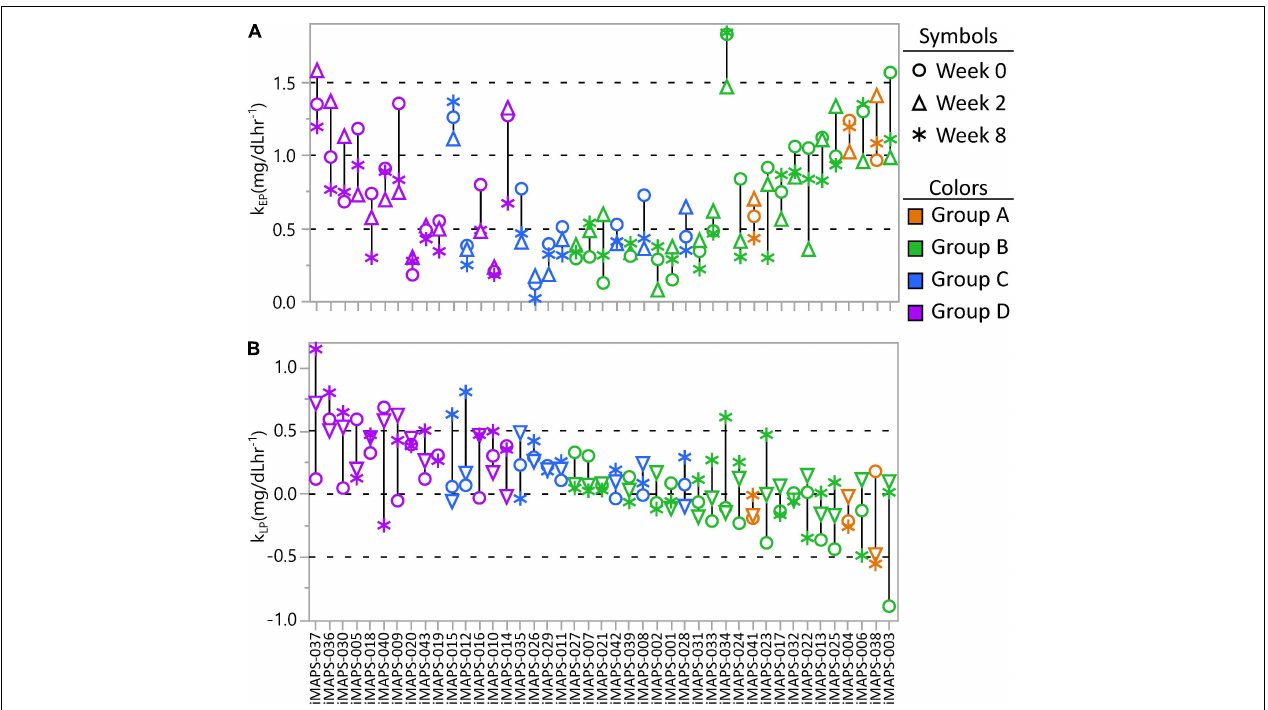
FIGURE 7 | The intra-individual variance in (A) early-phase postprandial triglyceride change (k EP ) and (B) late-phase postprandial triglyceride change (k LP ) from the plasma measured at 0, 2, and 8 weeks of the iMAPS dietary intervention. The 43 participants are ordered by decreasing k EP x k LP and colored by the median k EP x k LP kinetic quartile group (A, B, C, or D) of the three measurements. Considering all participants, and controlling for the participant as a random effect, EP increased ( p = 0.012) and k LP tended to decrease ( p = 0.06) over the 8-week intervention, but was not affected by diet type, age, or